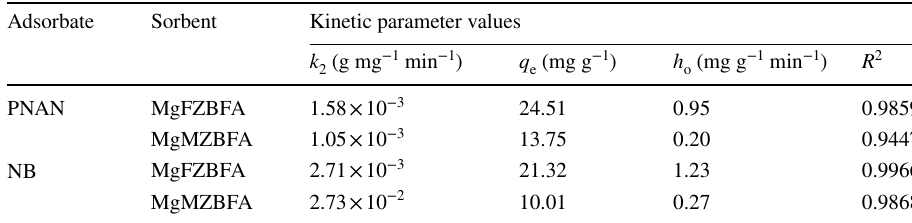
Table 8 Pseudo-second-order kinetic model parameters for the sorption of PNAN and NB